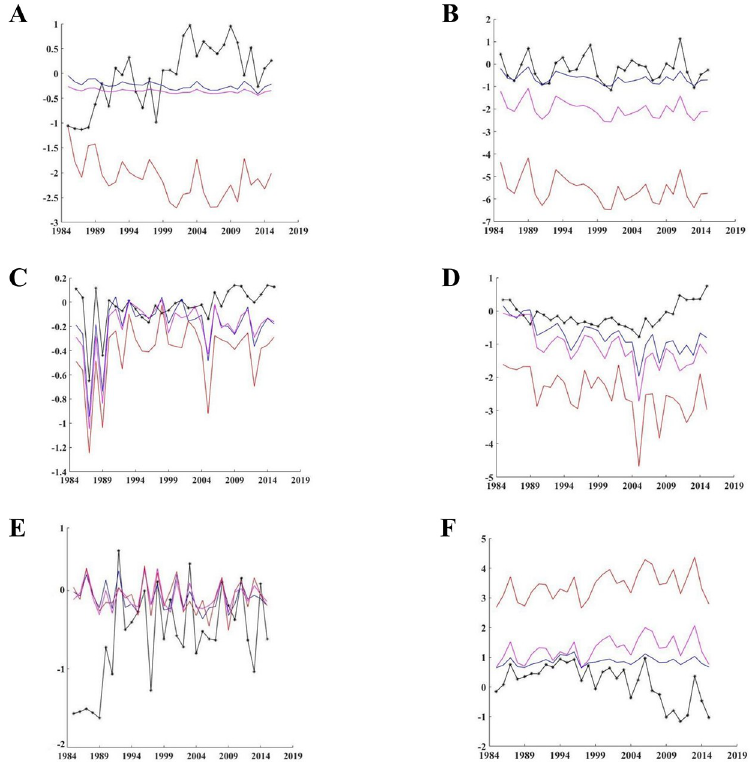
Fig 7. SST scenarios. Generated predictions by the DDDBN model (star symbol) versus the 1.0˚C (blue line), 1.5˚C (purple line) and 3.0˚C (red line) SST scenarios. Note, the negative scale is due to standardization.